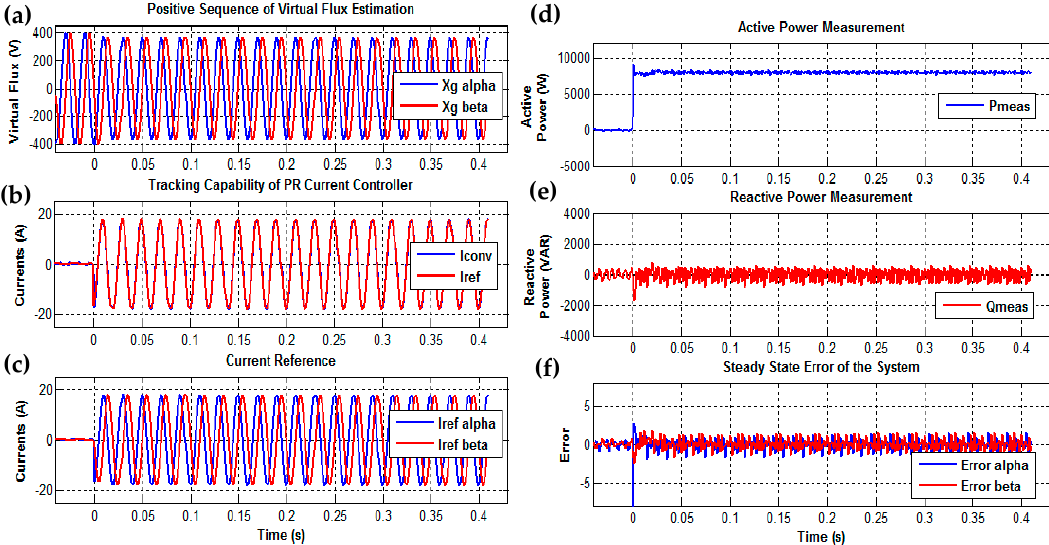
Figure 17. Active power change: ( a ) Positive sequence of virtual flux estimation; ( b ) Tracking capability of PR current controller; ( c ) Current reference generation; ( d ) Active power measurement; ( e ) Reactive power measurement; ( f ) Steady state error of the system.